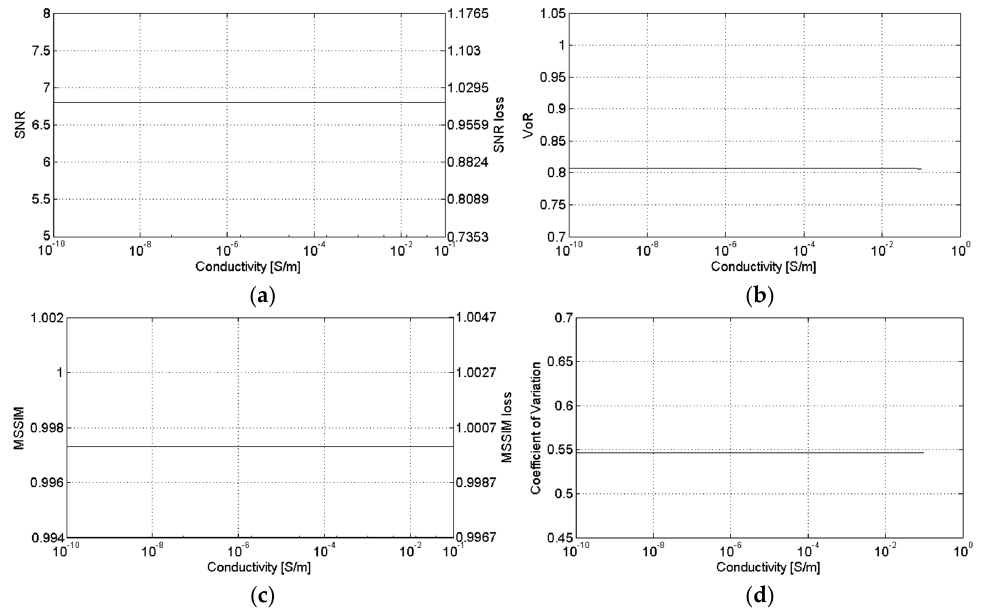
Figure 9. Sensitivity of SB-SARBM3D against the electrical conductivity: ( a ) SNR; ( b ) VoR; ( c ) MSSIM; ( d ) coefficient of variation.